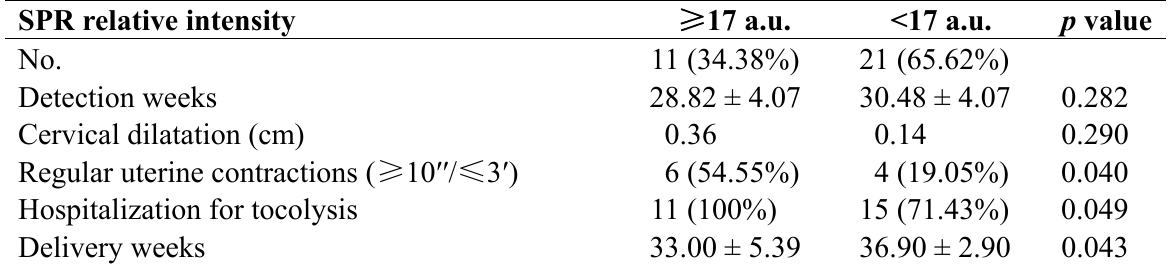
Table 2. Demographic data between SPR relative intensity ≥ 17 a.u. and <17